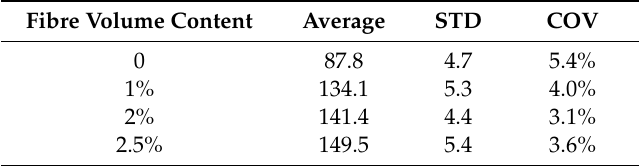
Table 8. Compressive strength of different groups of 100 mm cube specimens.